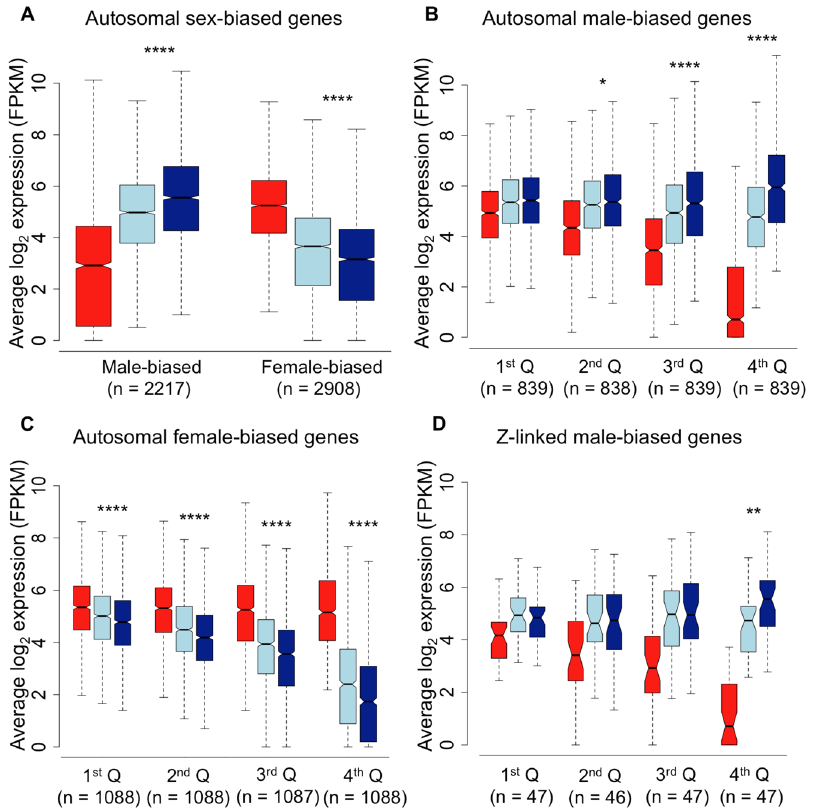
Figure 2. Average log 2 expression for all sex-biased genes. Panel A, autosomal male-biased and female-biased genes in females (red), subordinate males (light blue) and dominant males (dark blue). Panel B, autosomal male-biased genes ranked by male-bias. Panel C, autosomal female-biased genes ranked by female bias, and Panel D, Z-linked male-biased genes ranked by male-bias. Whiskers extend to the most extreme data point, excluding outliers that exceeded 1.5 6 the interquartile range. Significant p -values as calculated by Wilcoxon tests are indicated by asterisks above each comparison between dominant and subordinate males (* p , 0.05, ** p , 0.01, *** p , 0.001, **** p , 0.0001).